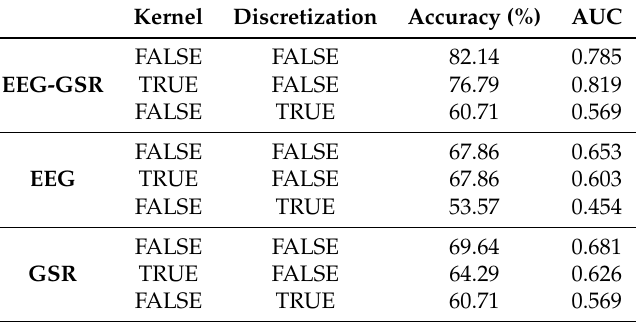
Table 7. NB hyperparameters’ tuning results.